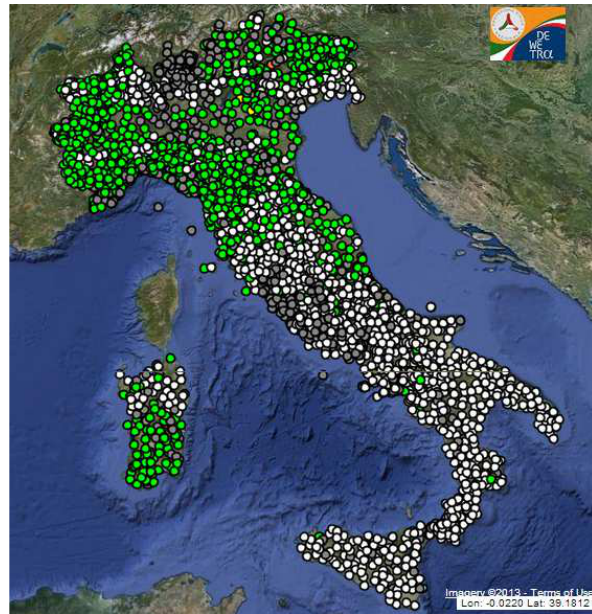
Figure 3: The distribution of more than 3000 rain gauges over Italy. The figure shows 1-hour 2 Fig. 3. The distribution of more than 3000 rain gauges over Italy. The figure shows 1h accumulated rain (sri) between 01:00 and accumulated rain (sri) between 01:00 and 02:00 UTC, on July 5, 2011 (i.e. the 1-hour period 3 02:00UTC on 5 July 2011 (i.e., the 1h period containing both containing both Figures 1 and 2). Rain gauges are indicated with circles and color coded as follows: 4 Figs. 1 and 2). Rain gauges are indicated with circles and color- grey → missing data; white →no rain; green→0<sri<T1, yellow→T1<sri <T2, orange → T2<sri<T3; 5 coded as follows: grey → missing data; white → no rain; green → 0<sri<T1; yellow → T1<sri<T2; orange → T2<sri<T3; red red → T3<sri, where Ti (with i=1-3) represent three thresholds for light, moderate, and intense 6 → T3<sri; where T i (with i = 1–3) represent three thresholds for rainfall, which values differ depending on respective catchment (data courtesy of DPC. Image 7 light, moderate, and intense rainfall, whose values differ depending obtained using DEWETRA). 8 on the respective catchment (data courtesy of DPC, image obtained using